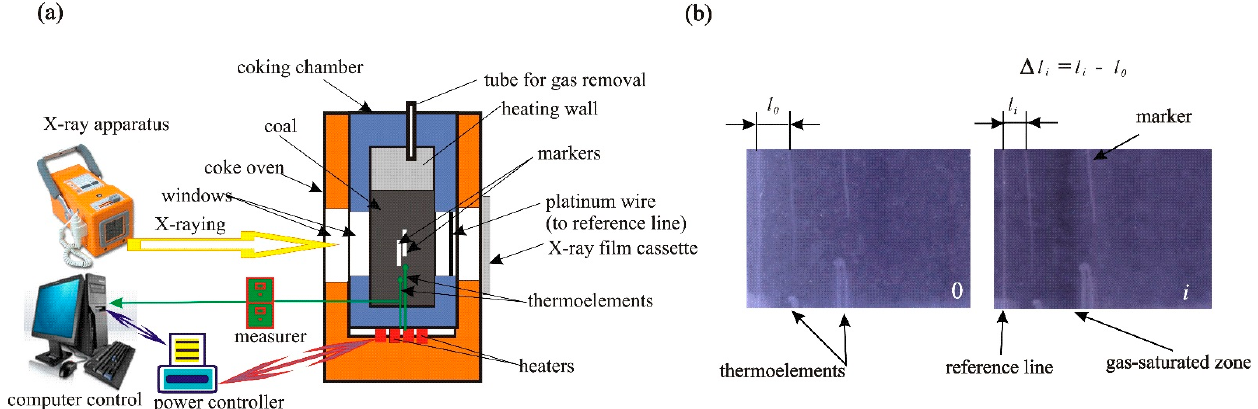
Figure 1. A scheme of the laboratory unit to study the carbonization process with X-raying ( a ) with X-ray pictures of heated charge of coals ( b ).